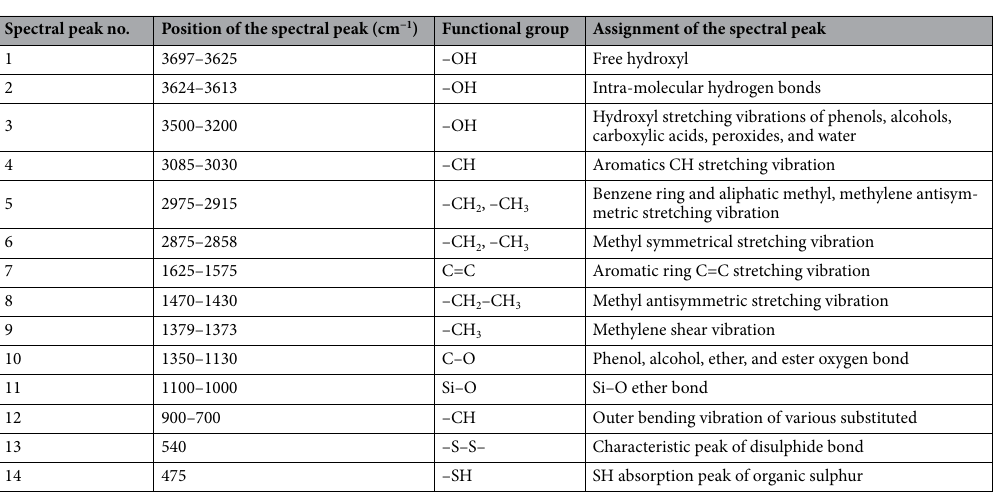
Table 5. Absorption peak characteristics of the coal samples.